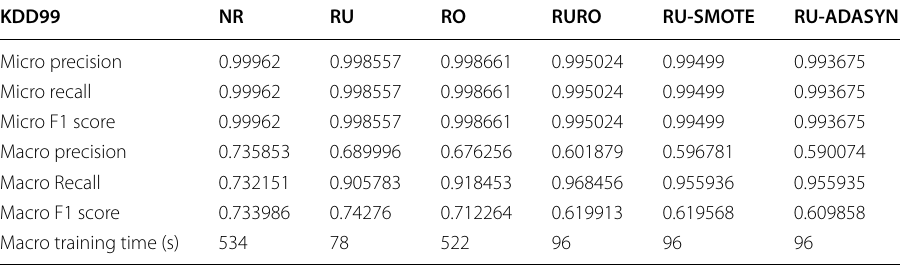
Table 11 ANN Classification results for KDD99 on AWS with Spark for various resampling methods